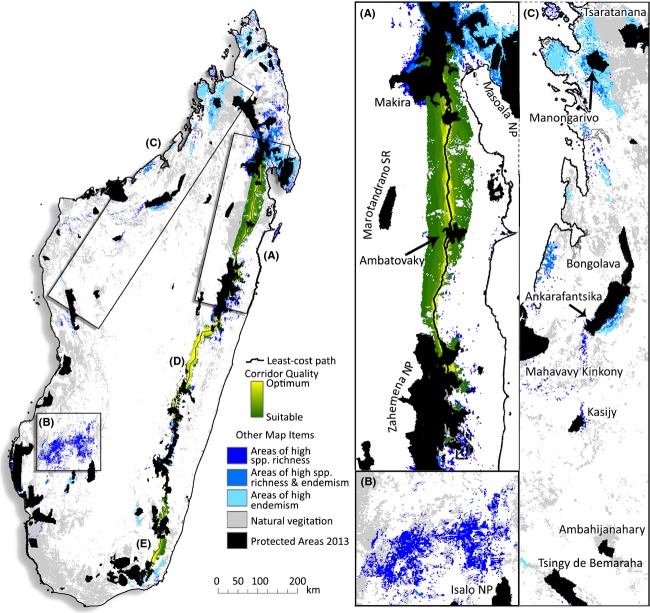
Conservation priority areas. Three regions of Madagascar with highest priority for protection and conservation of lemurs and their cohabitants. (A) Area 1 of highest conservation concern. Core range shift analyses suggest that many of the east-central populations may need to disperse northward via the forests between Zahamena NP, Ambatovaky, and Makira. Using least-cost corridors and estimates of high current and future species richness and micro-endemism, we identify a series of corridors that connect these regions – traversing the habitat of the highest suitability and ecological stability for the highest number of species. (B) Second priority area surrounding the Mangoky River. This area is predicted to be central in facilitating dispersal among southwestern ecotones, but also a region predicted to act as a sanctuary for many lemur species. (C) Third priority region identified is a wide range habitat in the NW. This region has experienced widespread deforestation and a stepping-stone reserve network combined with selective reforestation might be feasible. Two specific areas with high levels of micro-endemism in this region are the coastal forests near Ambaliha and Antsirabe (situated west of Manongarivo) and the coastal forests around the village of Mariarano (west of Bongolava). See Fig. S2 for information regarding D and E.